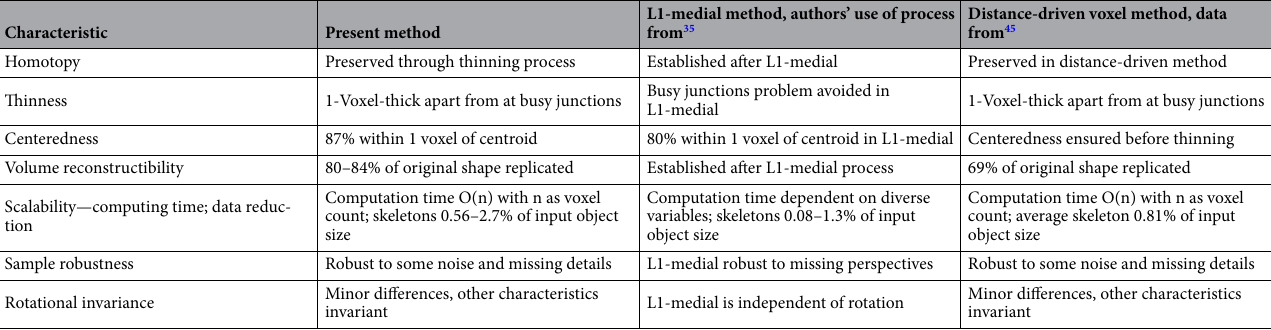
Table 1. Comparison of the present method, the L1-medial method applied to our PCs; and the findings of a previous study on a different voxel-thinning